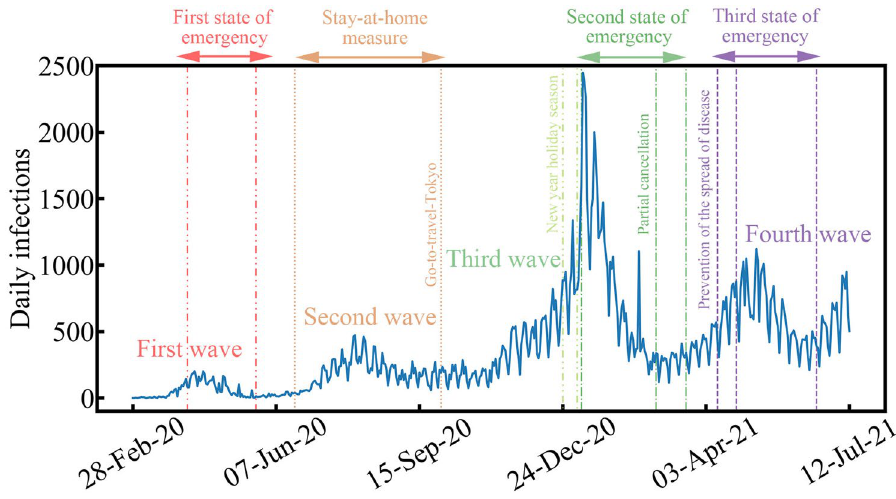
Figure 1. Daily COVID-19 infections in Tokyo, Japan, from February 28, 2020, to July 12,